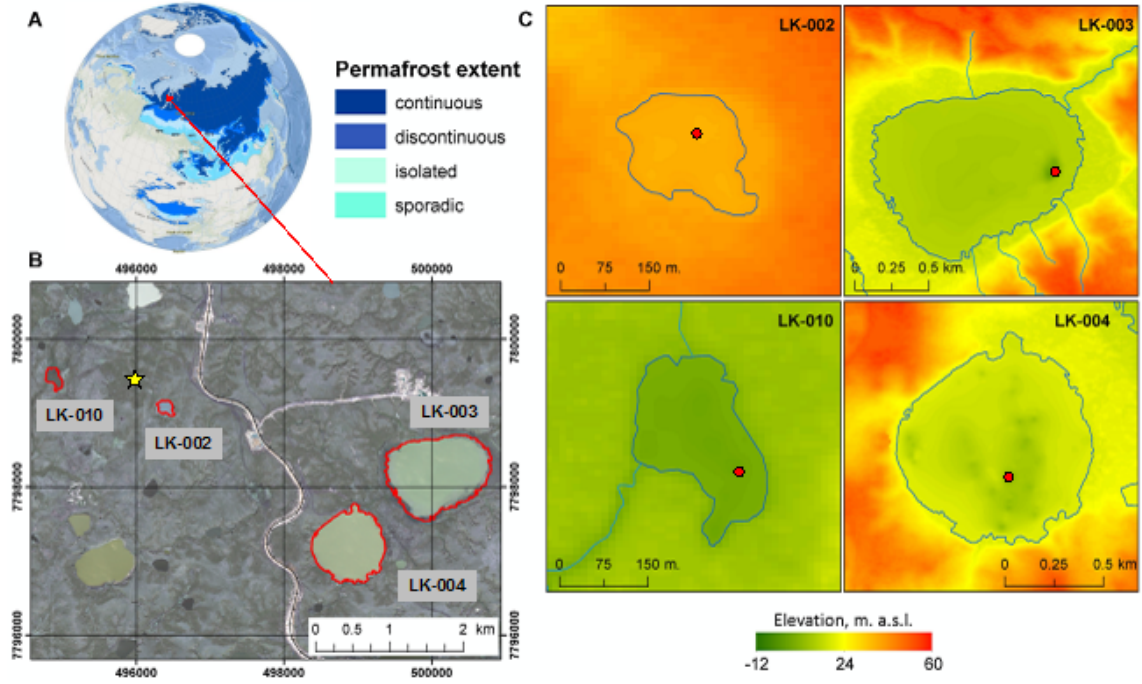
Figure 1. (a) An overview map of Eurasia with permafrost extent from Brown et al. (2002). (b) Study area map of Central Yamal. Red- outlined polygons indicate the lakes under study, and the yellow star indicates Vas’kiny Dachi research station. The orthorectified QuickBird satellite image acquired on 30 July 2010 was used as a background (source: Digital Globe Foundation©): datum – WGS-84; projection – UTM Zone 42N. (c) Topography of the lake basins under study: red dots indicate the sites of the water and sediment sampling, and elevations are given in the Baltic height system (1977). Table 1. Characteristics of Yamal lakes: morphometry, hydrological, and hydrochemical